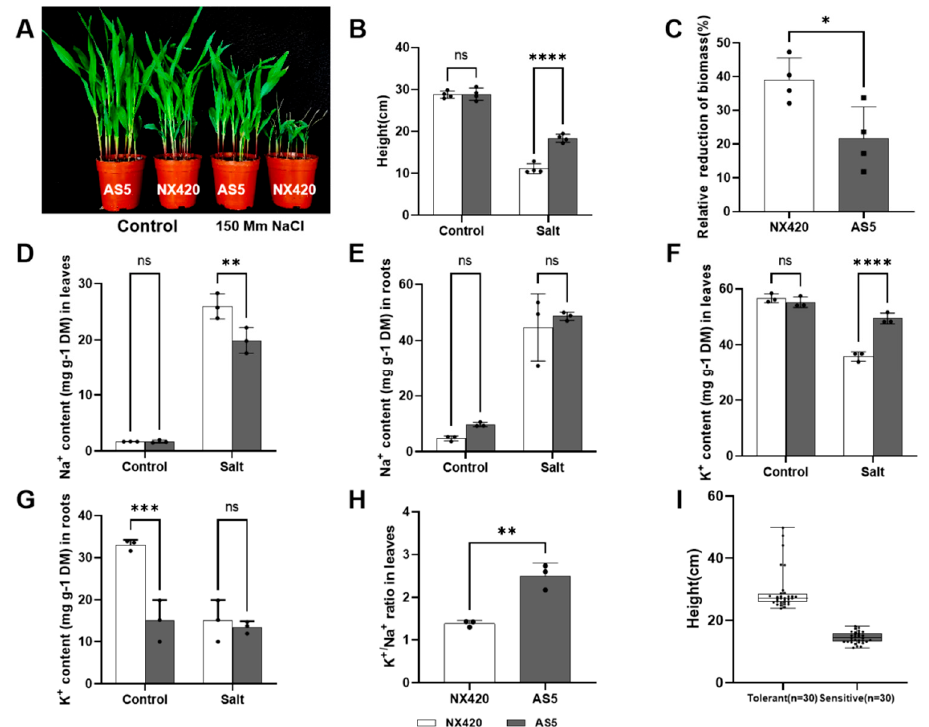
Figure 1. Identification of salt tolerance in AS5 and NX420. ( A ) The seedlings of AS5 and NX420 were treated with 150 mM NaCl for 14 days. ( B , C ) Plant height and the reduction in biomass. ( D , E ) Na + content in leaves and roots. ( F , G ) K + content in leaves and roots. ( H ) K + :Na + ratios in leaves. ( I ) Plant height of extremum population. The bar is 10 cm. *, p < 0.1; **, p < 0.01; ***, p < 0.001; ****, p < 0.0001, ns is no significant